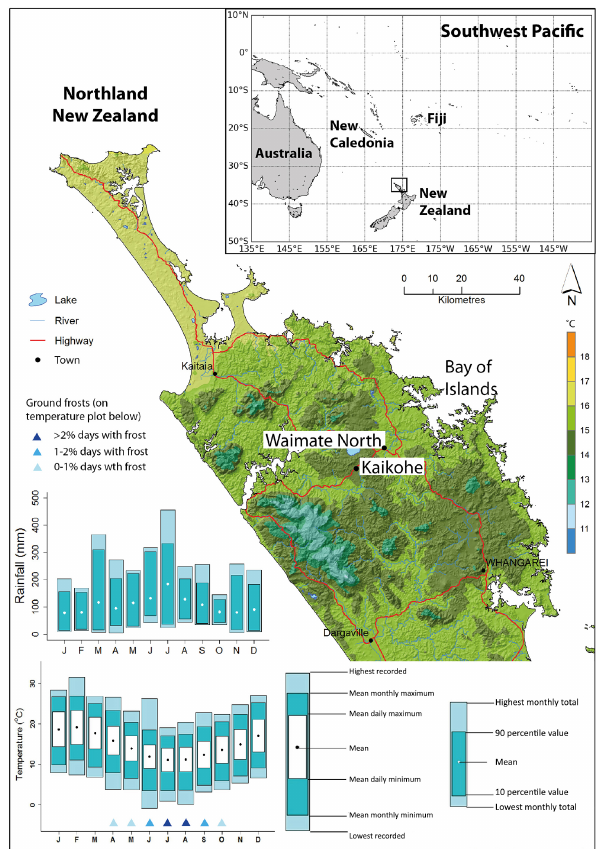
Figure 2. Map of Northland, New Zealand, including major points of interest in Reverend Richard Davis’ meteorological diary. The inset map shows New Zealand’s location in the southwest Pacific and a box around the Northland region. The base map displays the median annual temperature for the region, based on the 1981–2010 climatology period (temperature legend on right). The top bar plot shows monthly rainfall (1985–2010 period) and the bottom bar plot shows monthly temperature (1985–2010 period) for Kaikohe, with frost day occurrences (triangles) inset on the temperature